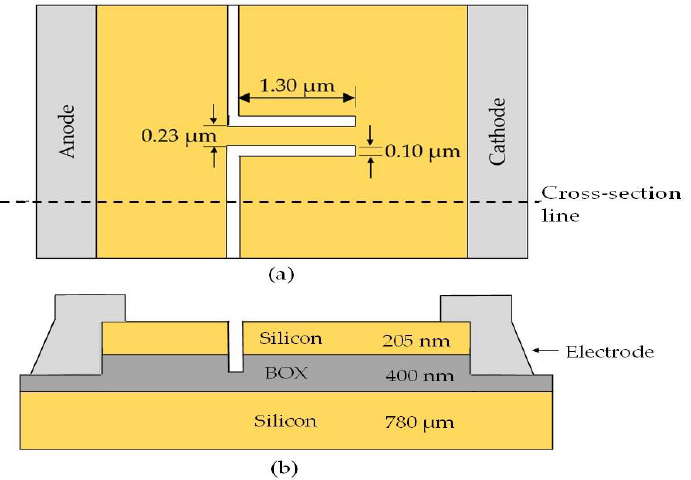
Figure 2. ( a ) Structural parameters of an SOI-based SSD, showing three main control factors: L, W, and Wt, and ( b ) the cross-section of the device [32].